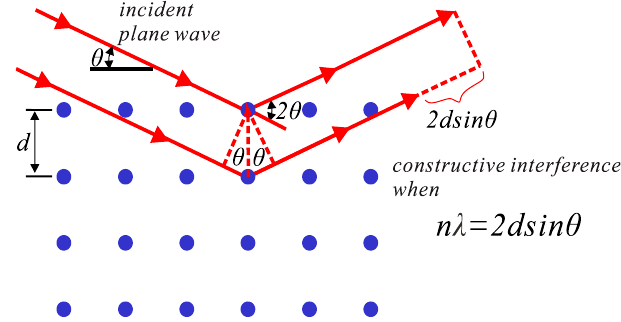
Figure 3. Schematic diagram of Bragg ’ s diffraction law [32] .